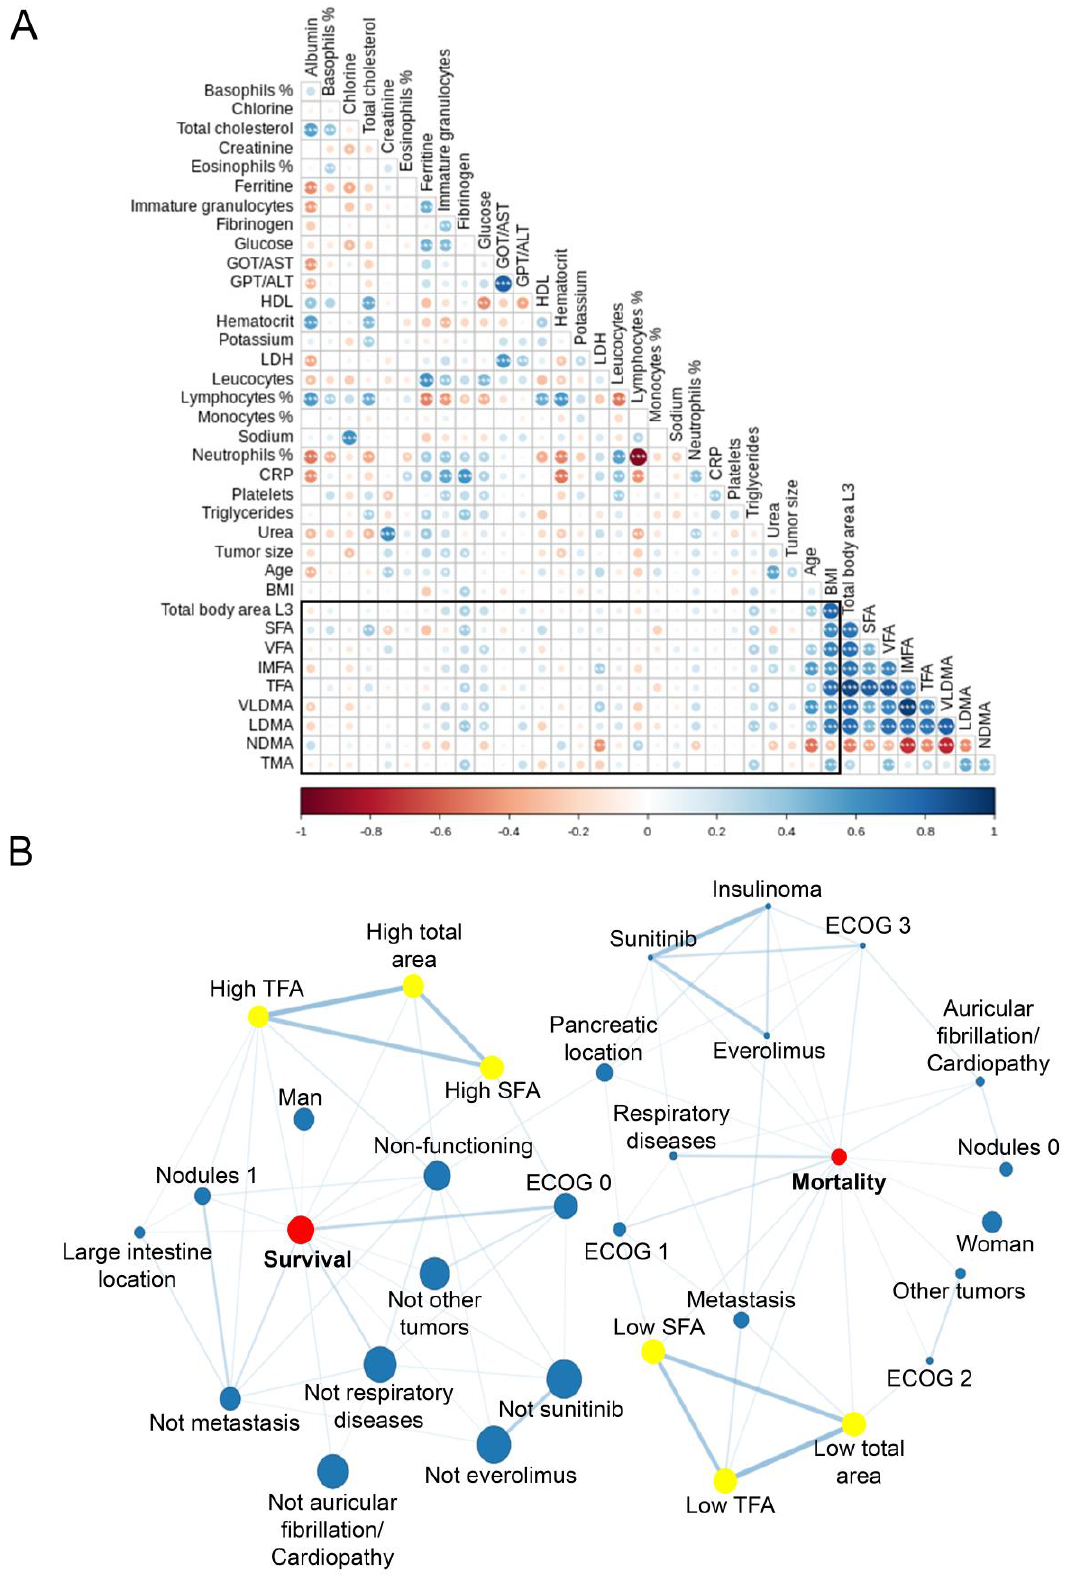
Figure 2. Relationships between body composition measures and clinical and biochemical variables. ( A ) Spearman’s rho correlation matrix between body composition at L3 CT images and continuous variables. Blue intensity corresponds to positive correlations whereas red one indicates those that